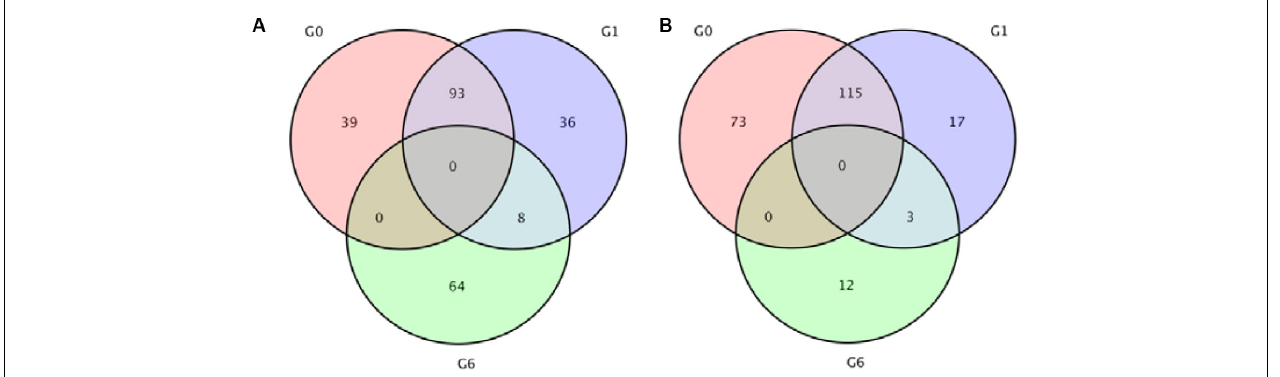
FIGURE 6 | Venn diagrams indicating the differentially expressed genes in 48 and 96 h after ammonia exposure. (A) Upregulated genes; (B) downregulated